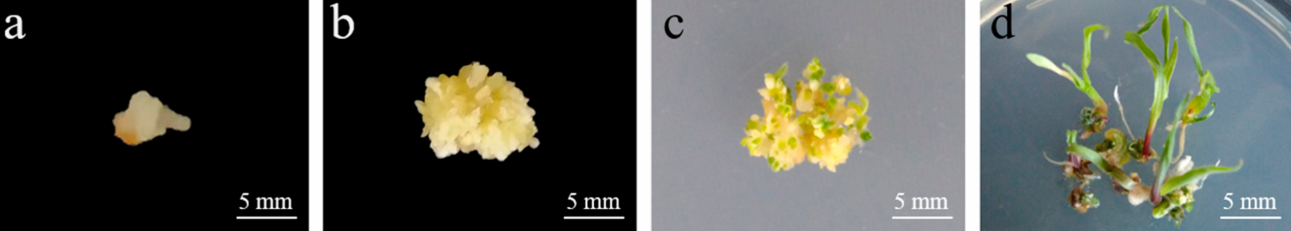
Figure 1. Features of the cultures during induction and differentiation stages. ( a ) Non-embryogenic callus (NEC). ( b ) Embryogenic callus (EC). ( c ) EC with green spots. ( d ) Regenerated plantlets. Bars = 5